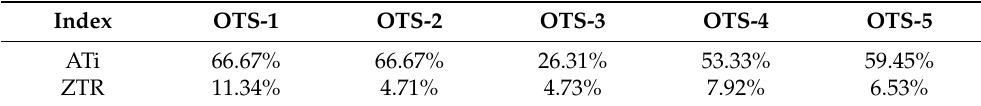
Table 4. Heavy mineral index of